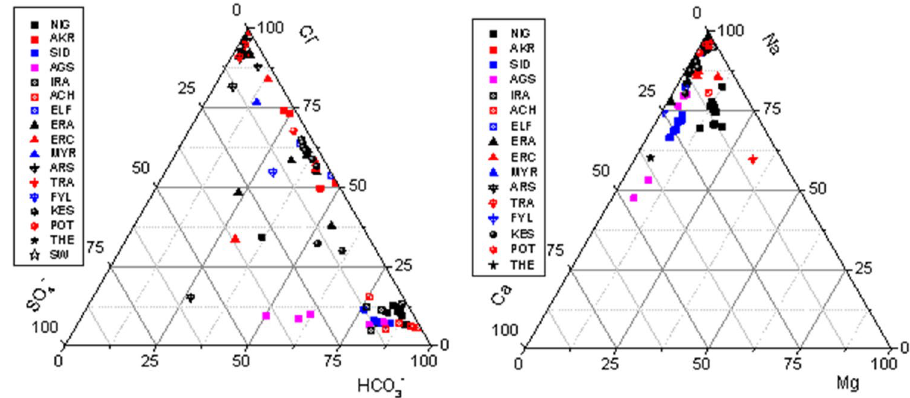
Figure 2. Ternary plots of Cl–HCO 3 –SO 4 and Na–Ca–Mg for all studied